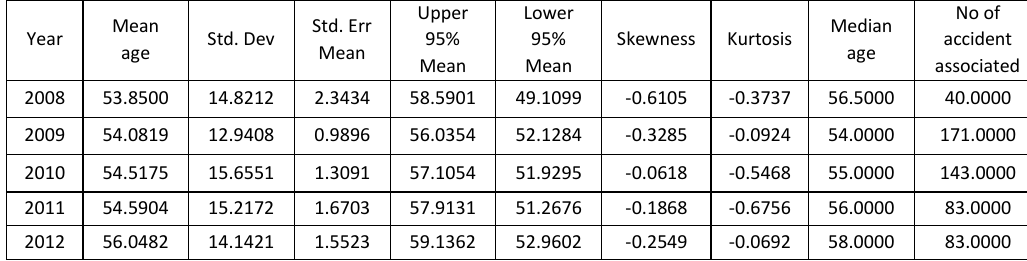
TABLE A2: DESCRIPTIVE STATISTICS SUMMERY: ASSOCIATED NUMBER OF ACCIDENTS WITH MEAN AGE PER YEAR FROM 2008 TO